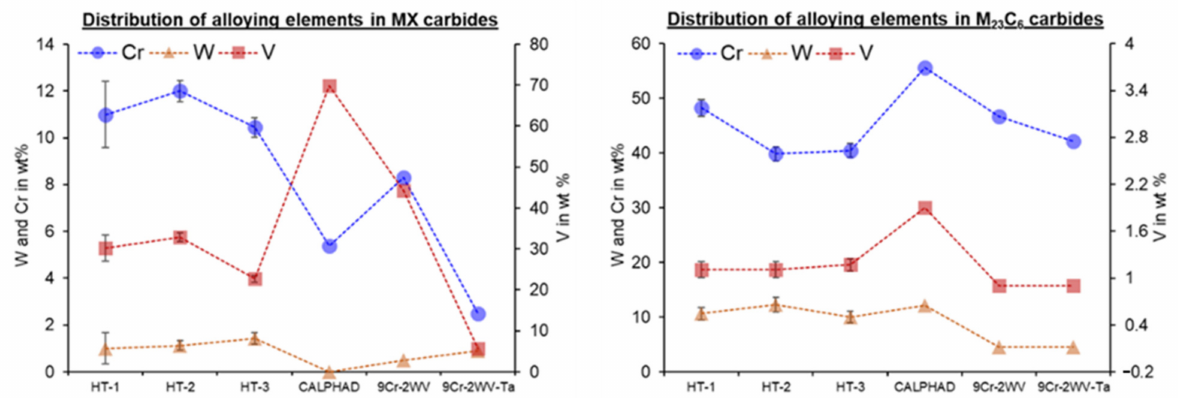
Figure 19. Shows the distribution of elements in MX and M 23 C 6 for all the PWHTs. Cr and W refer to the left y -axis, V refers to the right y -axis. Cr content in the matrix (around 8.4% to 8.8%) contributed to the higher amount of Cr measured using STEM